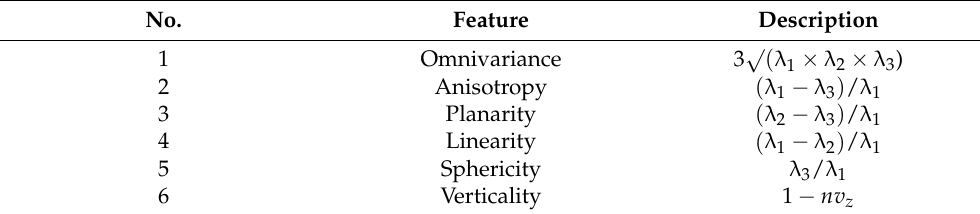
Table 2. Six geometric features extracted from the point cloud. z represents the height of the point cloud, nv is the normal vector, and λ i the eigenvalues. No.